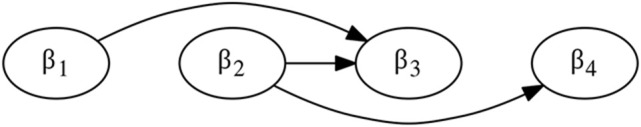
The dependency graph DG(t) for DCJ scenario t defined in Figure 1D.